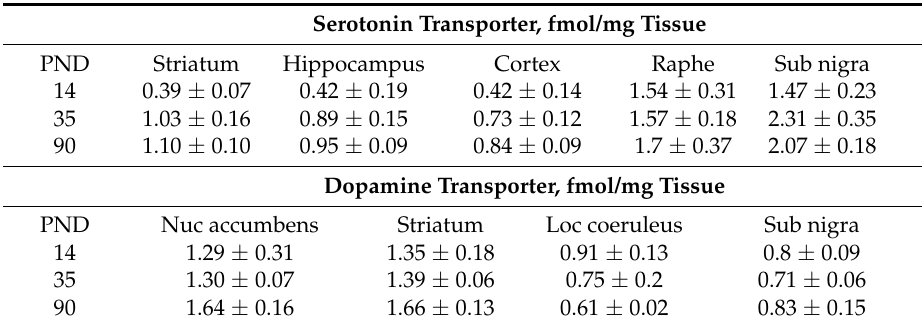
Table 2. Control Levels of Serotonin and Dopamine Transporters during Postnatal Development.